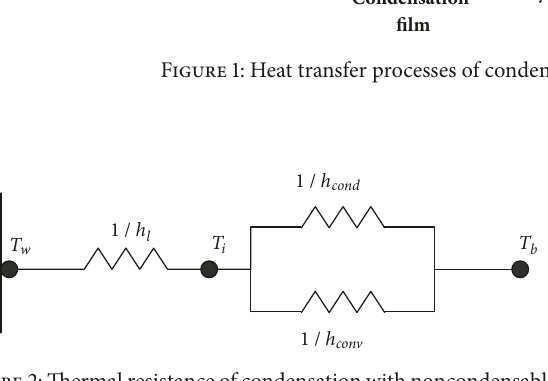
Figure 2: Thermal resistance of condensation with noncondensable